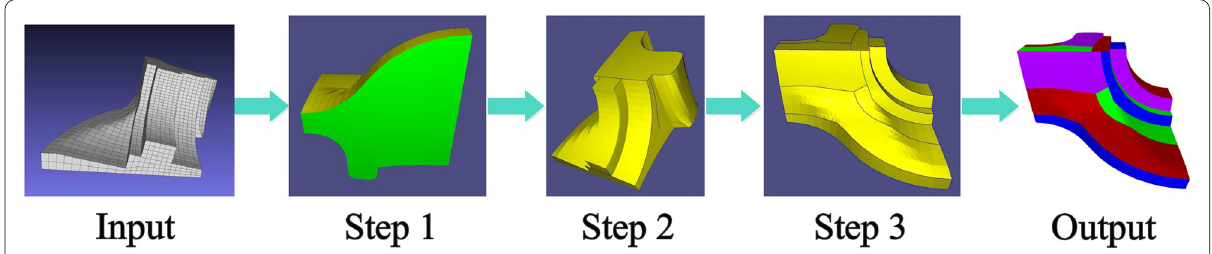
Fig. 3 Pipeline of the segmentation